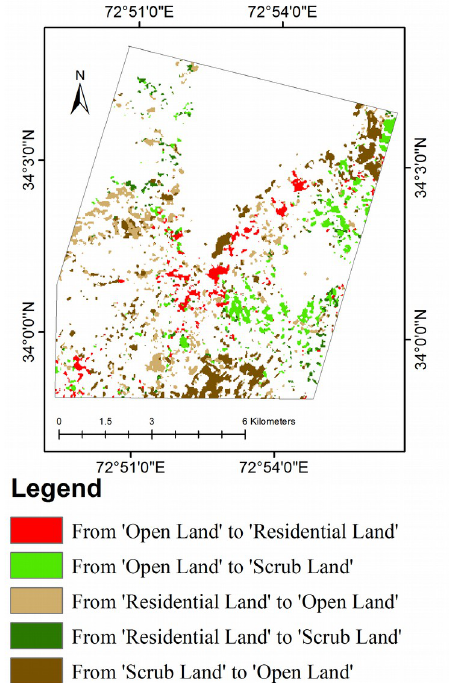
Figure 4. Winter to autumn seasonal change detection 3.6 Seasonal Change Detection from Spring to Summer Change detection matrix (Table 5) from spring to summer shows decrease of spatial mapping of forest 48.8%, waterway 15.6%, scrub land 63.4% and increase of open land 157.4%, reservoir water 30.8% and residential land 33.8%. Figure 5 shows category changes from residential land to open land, scrub land to open land which resulted increase of open land. Similarly category change from open land to reservoir land, residential land to reservoir land, waterway to reservoir land and scrub land to reservoir land resulted increase of reservoir water. A change of category from opens land to scrub land, forest to scrub land and scrub land to residential land resulted due to seasonal change. Change detection from spring to summer resulted reduction of vegetation and shallow water and increase of open land and reservoir